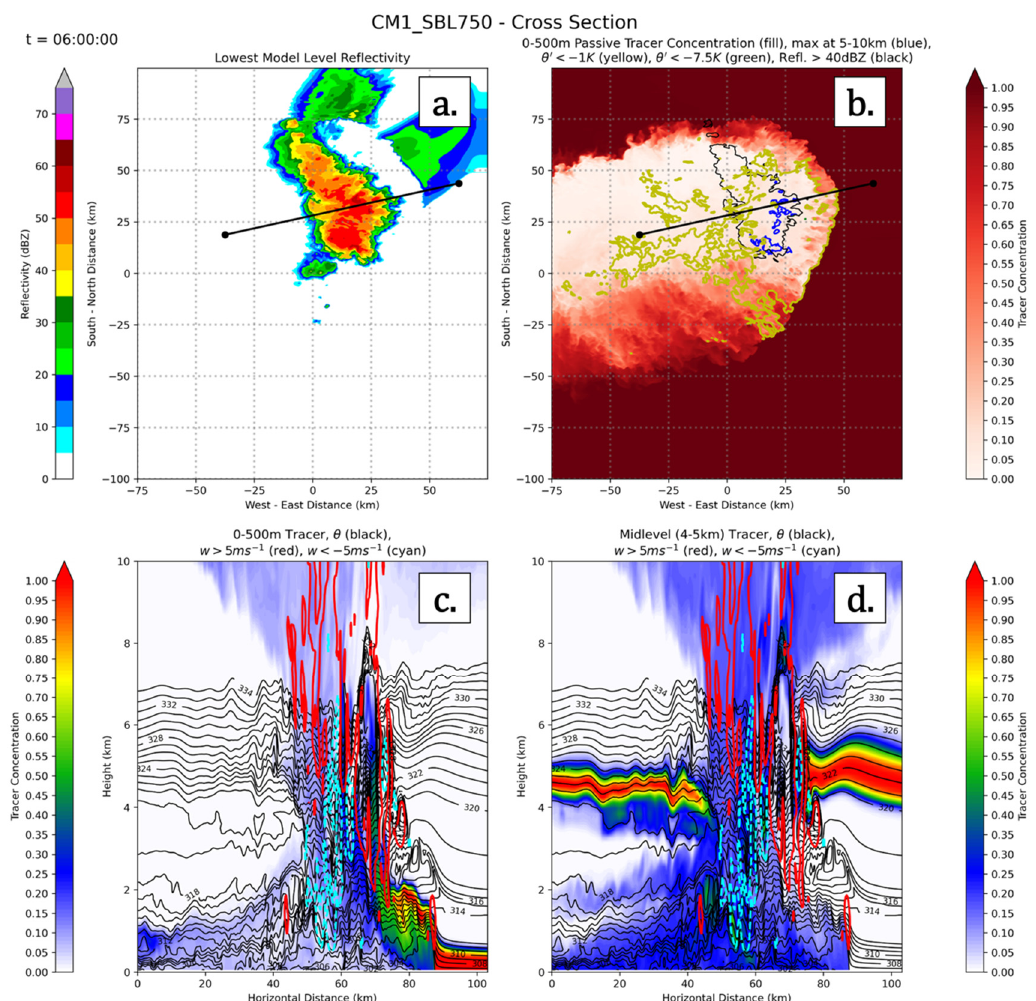
Figure 16. As in Figure 14, but for the CM1 SBL750 experiment at t = 6 h.